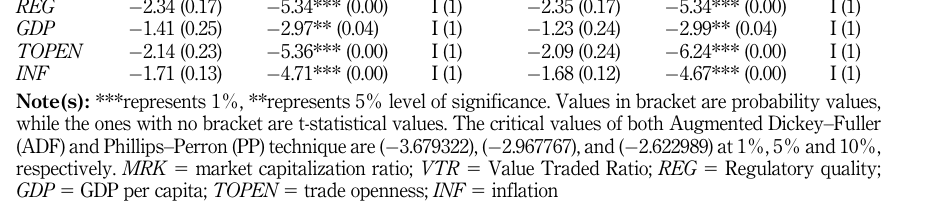
Table 6. Unit root test